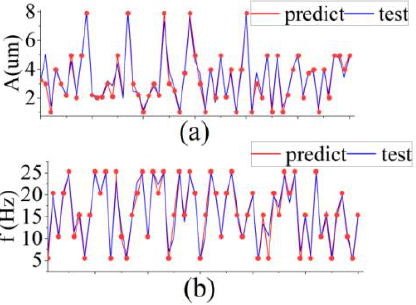
Figure 10. Vibration measurements on SMI experimental data. ( a ) Measurement of A in the range of 0~8 µm. ( b ) Measurement of f in the range of 5~25 Hz.